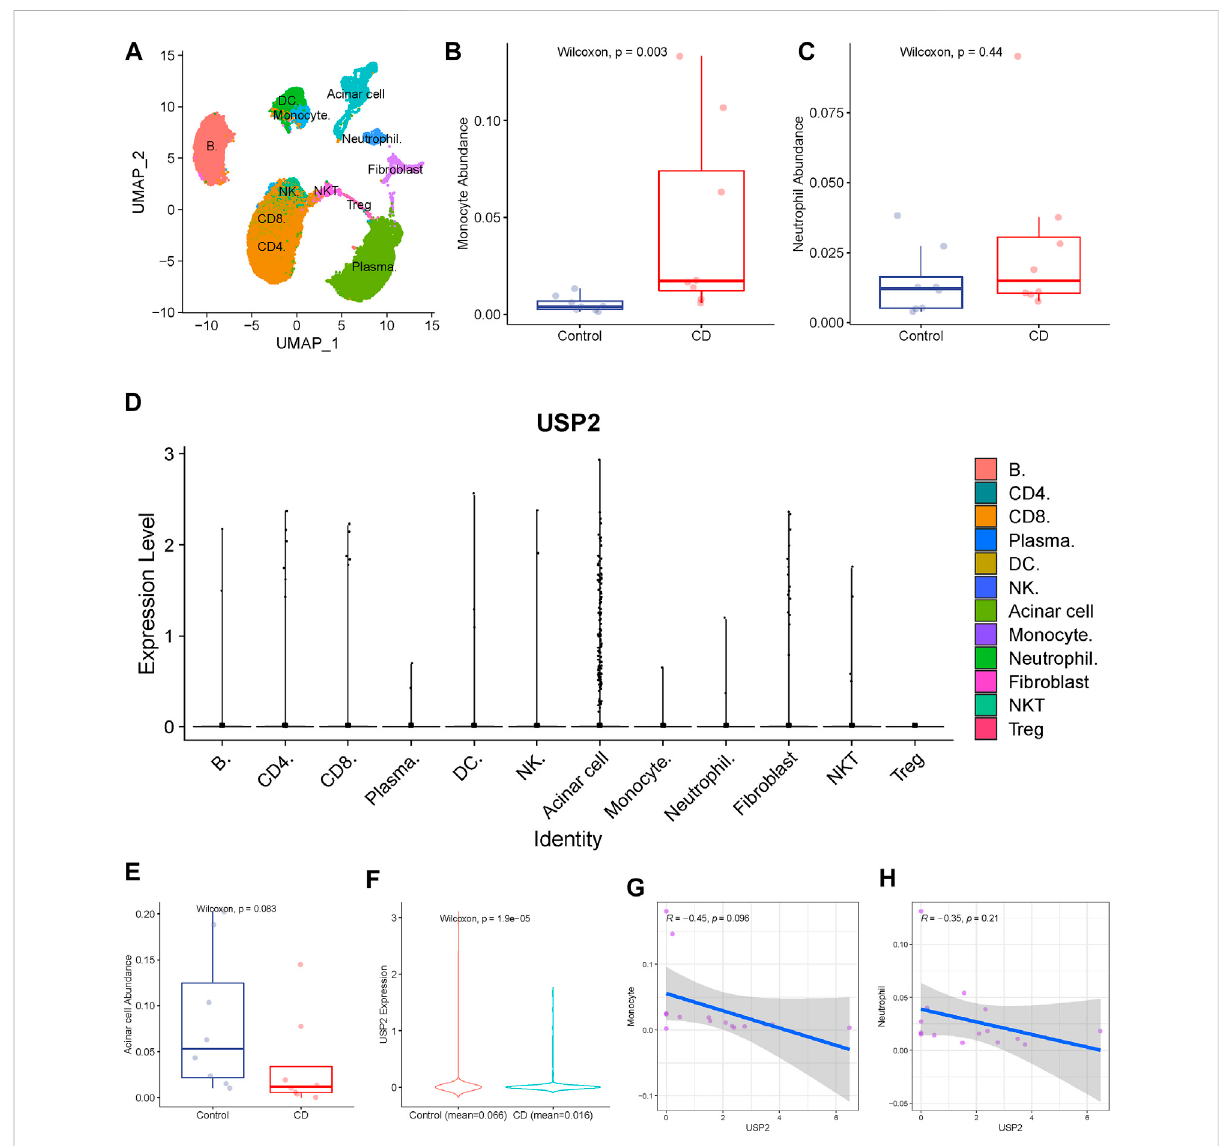
FIGURE 5 Validation of the association of USP2 with immunecells. (A) Total of 60,228 cells from 16 samples were clustered into 12 subsets. (B) Monocyte was upregulated in CD than in the control group. (C) USP2 expression levels were compared across different cell types, and USP2 has the highest expressionvalueinacinar cells. (D) AcinarcellwasupregulatedincontrolthaninCD,althoughtherewasnosigni fi cantdifference(Wilcoxontest; p = 0.083). (E) USP2 was also upregulated in acinar cells of the control group than in the CD group. (G – H) USP2 expression in acinar cells was negatively correlated with the abundance of monocyte and neutrophil, although there was no signi fi cant